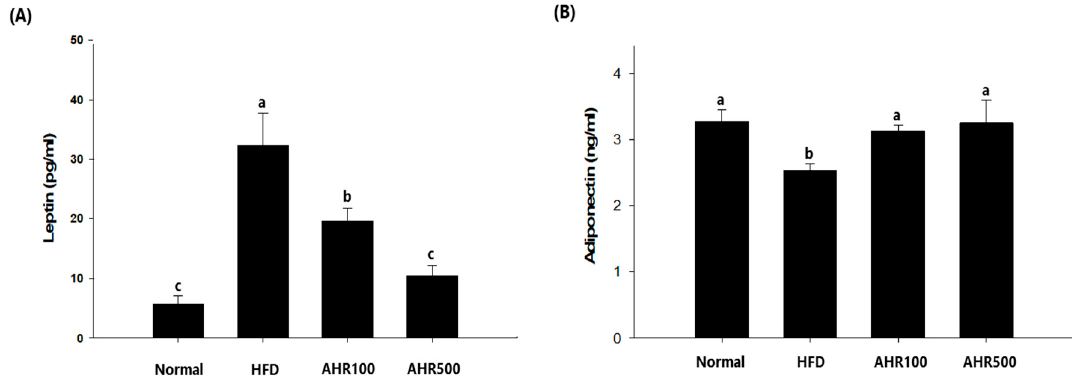
Figure 4. Effects of AHR on serum leptin ( A ) and adiponectin ( B ) concentrations in HFD-induced obese mice. Data are expressed as mean ± SEM ( n = 6–8). Values with different letters are significantly different at p < 0.05.